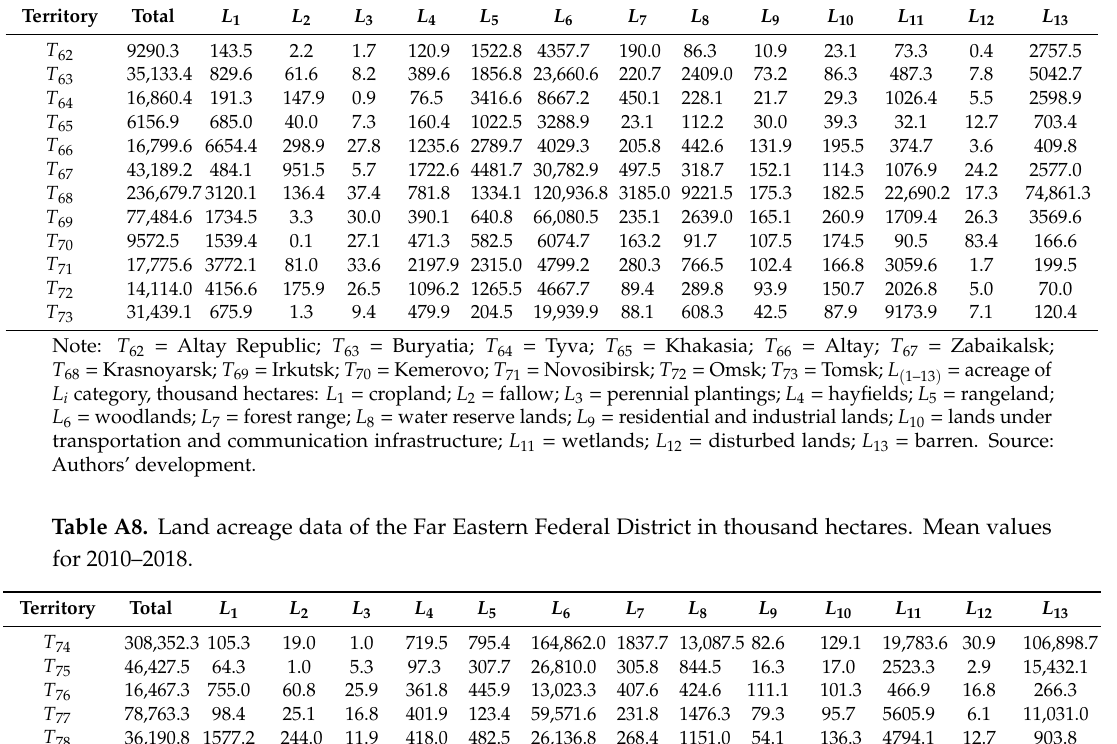
Table A7. Land acreage data of the Siberian Federal District in thousand hectares. Mean values for 2010–2018.